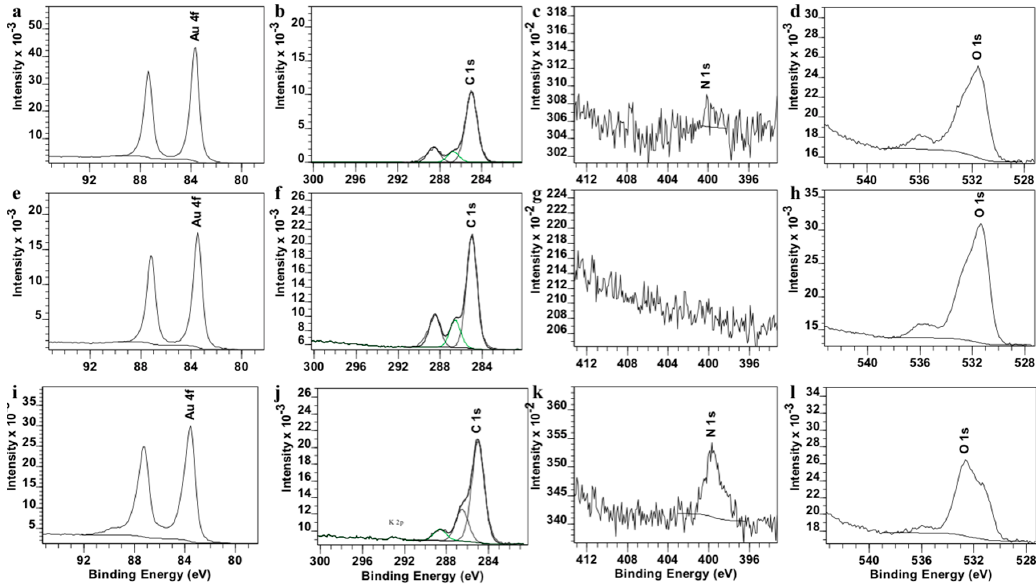
Figure 3. XPS deconvolution of Au 4f ( a , e , i ), C1s ( b , f , j ), N ( c , g , k ), and O ( d , h , l ) of AuNPs ( a – d ), PEGAuNPs ( e – h ), and PEGAuNPsVarl ( i – l ).